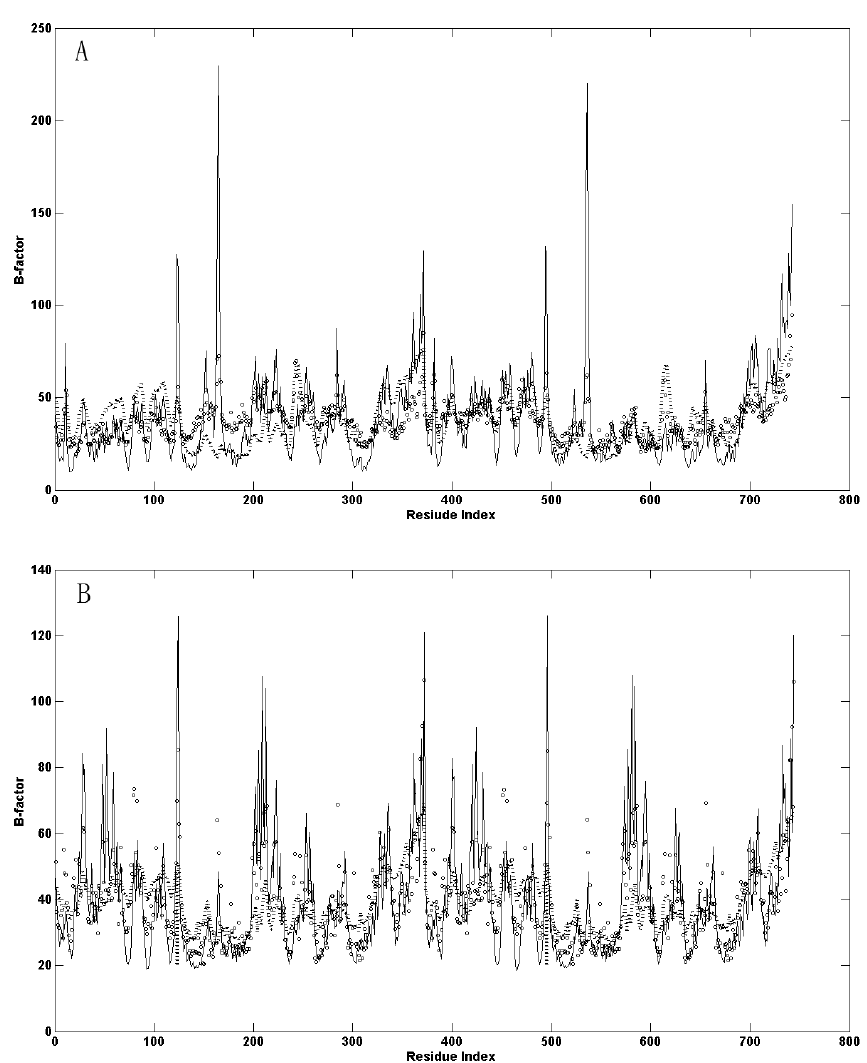
Figure 2. ( A ) The calculated B-factors based on the Gaussian network model (GNM) (circle curve) and the anisotropy elastic network model (ANM) (solid curve) compared to the experimental data (dotted curve) for the open-apo structure of L - Mt AlaDH (PDB code: 2OVE); and ( B ) The calculated B-factors based on GNM (circle curve) and ANM (solid curve) compared to the experimental data (dotted curve) for the closed-holo structure of L - Mt AlaDH (PDB code: 2VHZ).